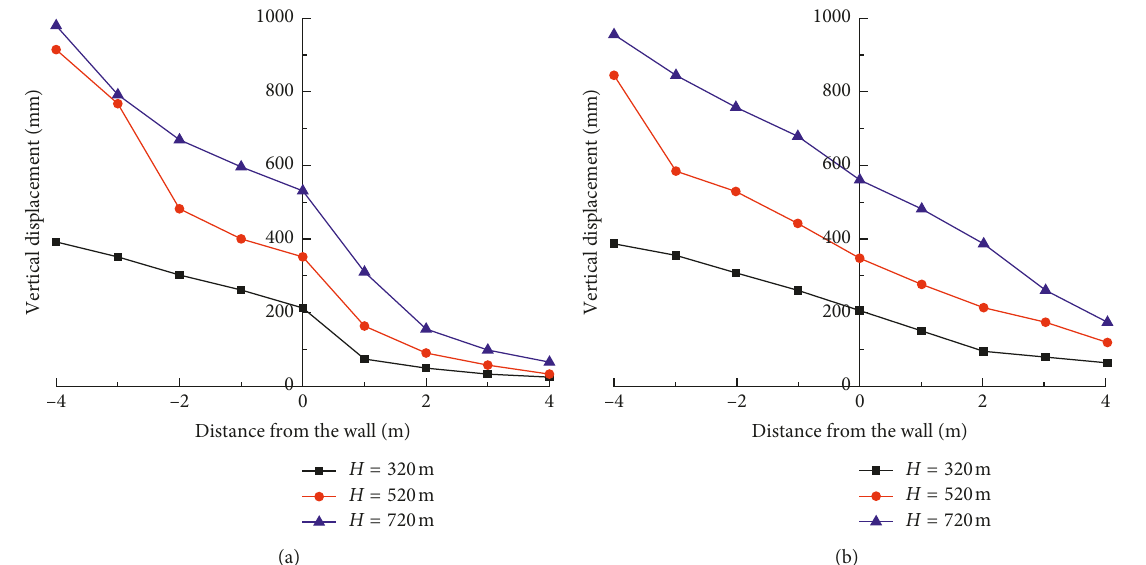
Figure 9: Vertical displacements of different layers of top coal with different thickness in 1.5m thick medium-strength hard coal gangue. (a) Upper top coal. (b) Lower top coal.